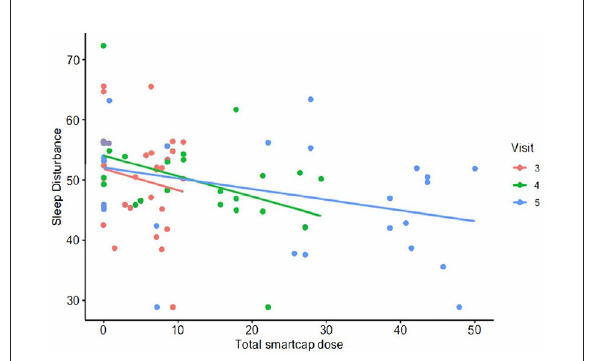
FIGURE2 The PROMIS T-score for sleep disturbance plotted vs. total smart cap dose of